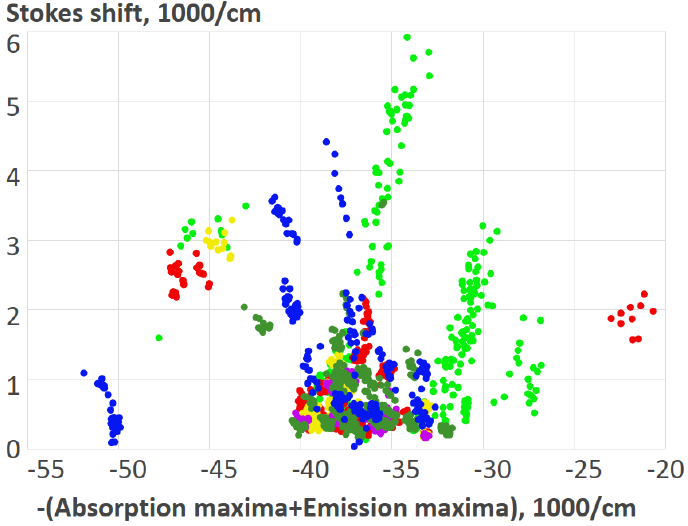
Figure 4. Stokes shift versus − (Absorption + Emission maxima) plot in terms of 1000/cm for a six- cluster dataset of 115 BODIPYs. For the key for the clusters, see Schemes 1 – 6 and Figure 3.